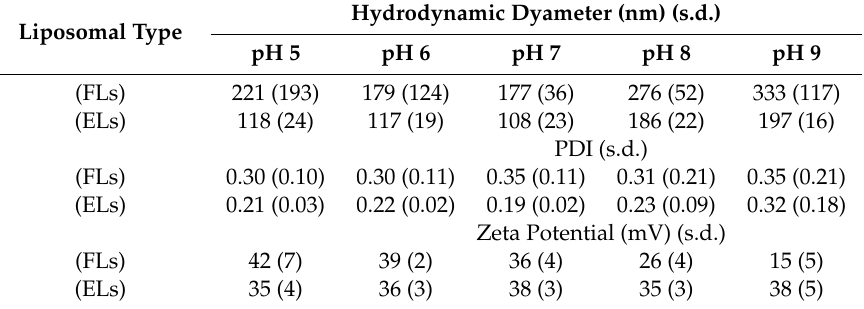
Table 5. pH dependence of the hydrodynamic diameter, polydispersity index (PDI) and zeta potential of fusogenic (DOPE / DOTAP / TFPE-head 1 / 1 / 0.1 mol / mol) (FLs) and endocytic (DOPC / DOTAP / TFPE-head 1 / 1 / 0.1 mol / mol) (ELs) liposomes. Experiments were performed in a PBS bu ff er titrated to the indicated pH. Given are averages over three independent measurements and, in parentheses, their standard deviations.